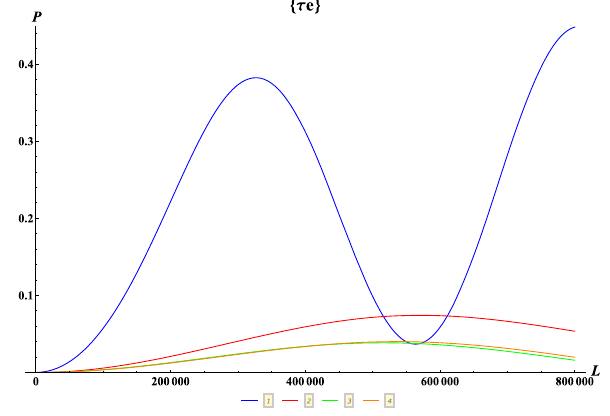
Fig. 12 Same analysis of Fig. 10, but for P ν